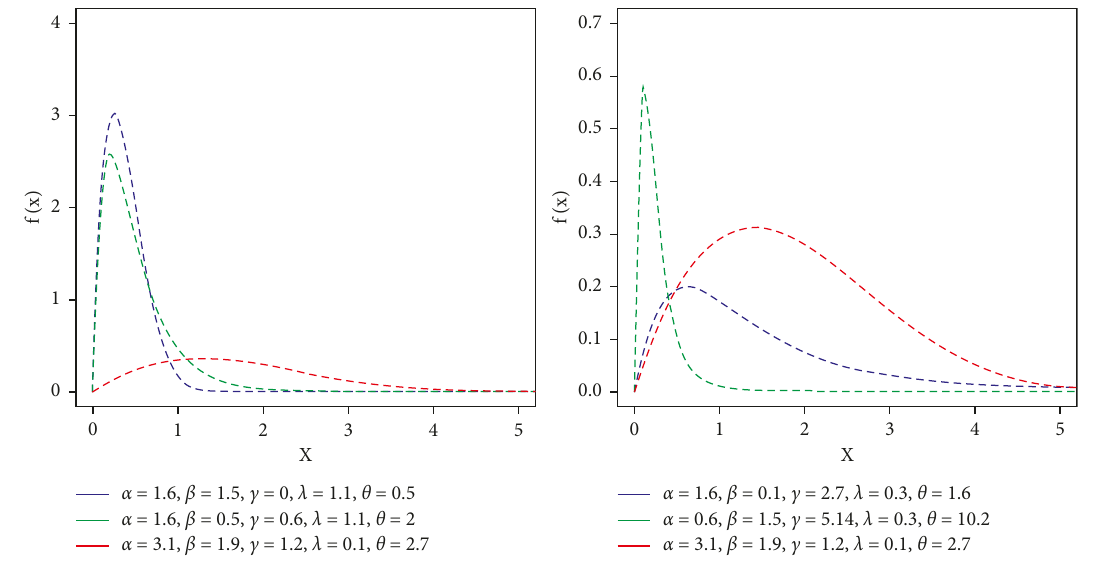
Figure 1: PDF plot of GA_L